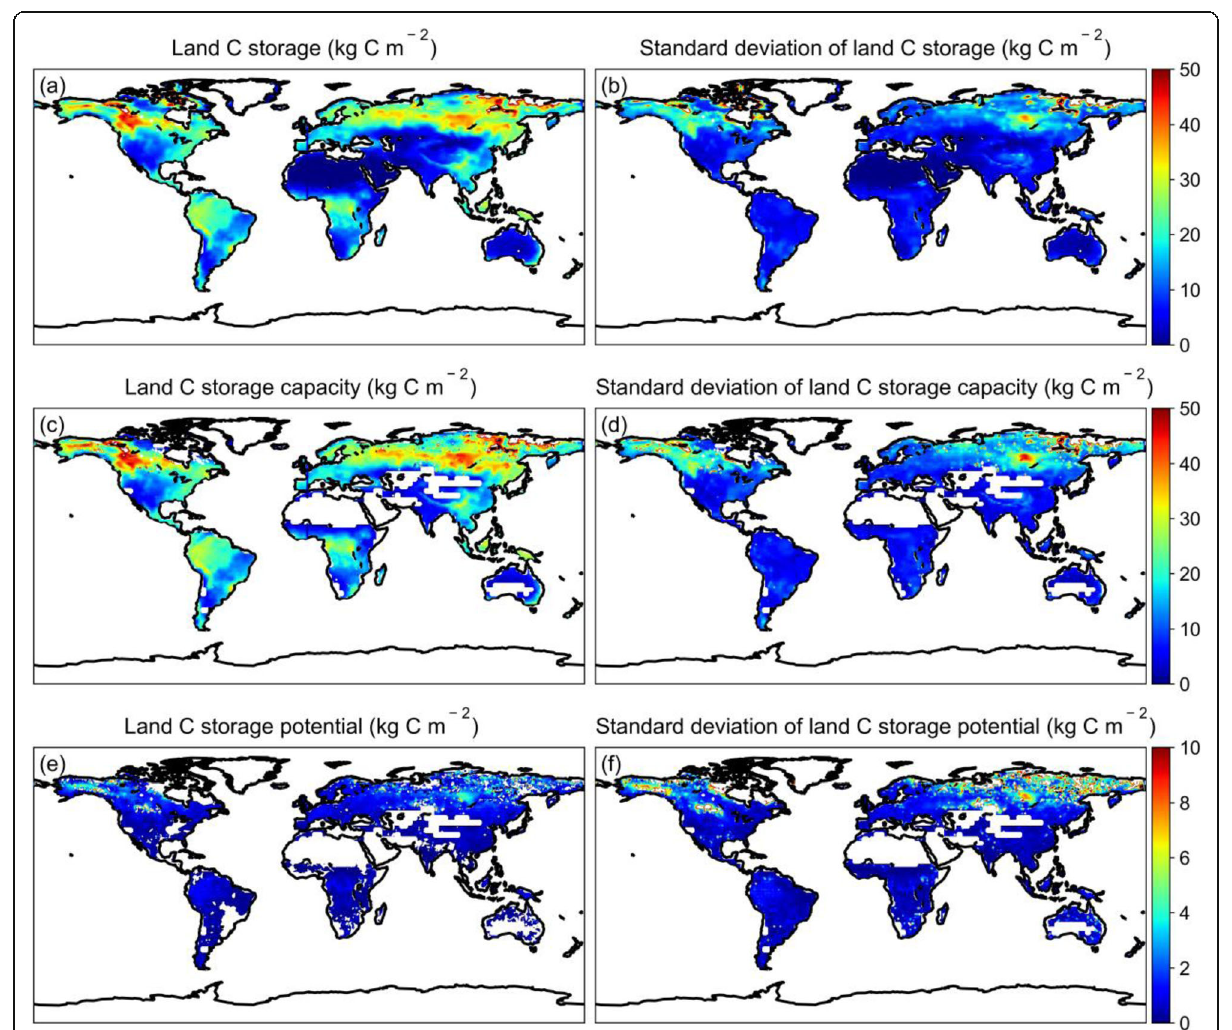
Fig. 6 The spatial distribution of the mean land carbon storage ( a ), land carbon storage capacity ( c ), and potential ( e ) simulated by seven models from CMIP6 during 1850 to 2014, and the standard deviation of land carbon storage ( b ), land carbon storage capacity ( d ), and potential ( f ) from these